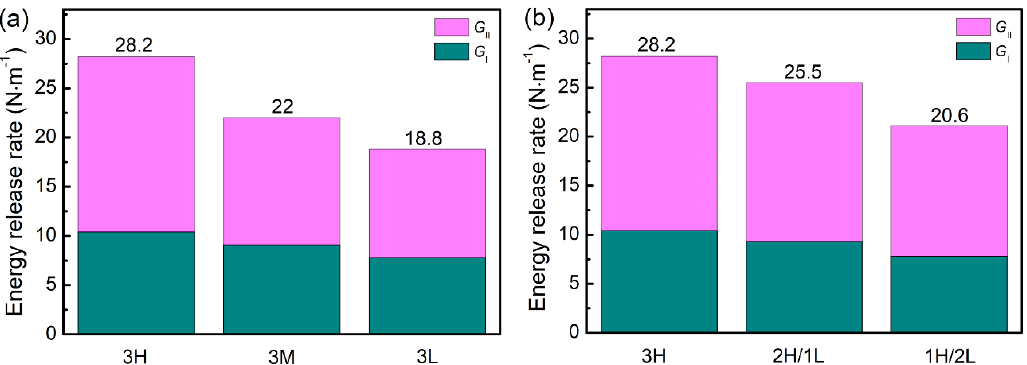
Fig. 59 Energy release rates under different designs: (a) overall modulus reduction design and (b) sublayer structure design. Reproduced with permission from Ref. [354], © Published by Elsevier Ltd.